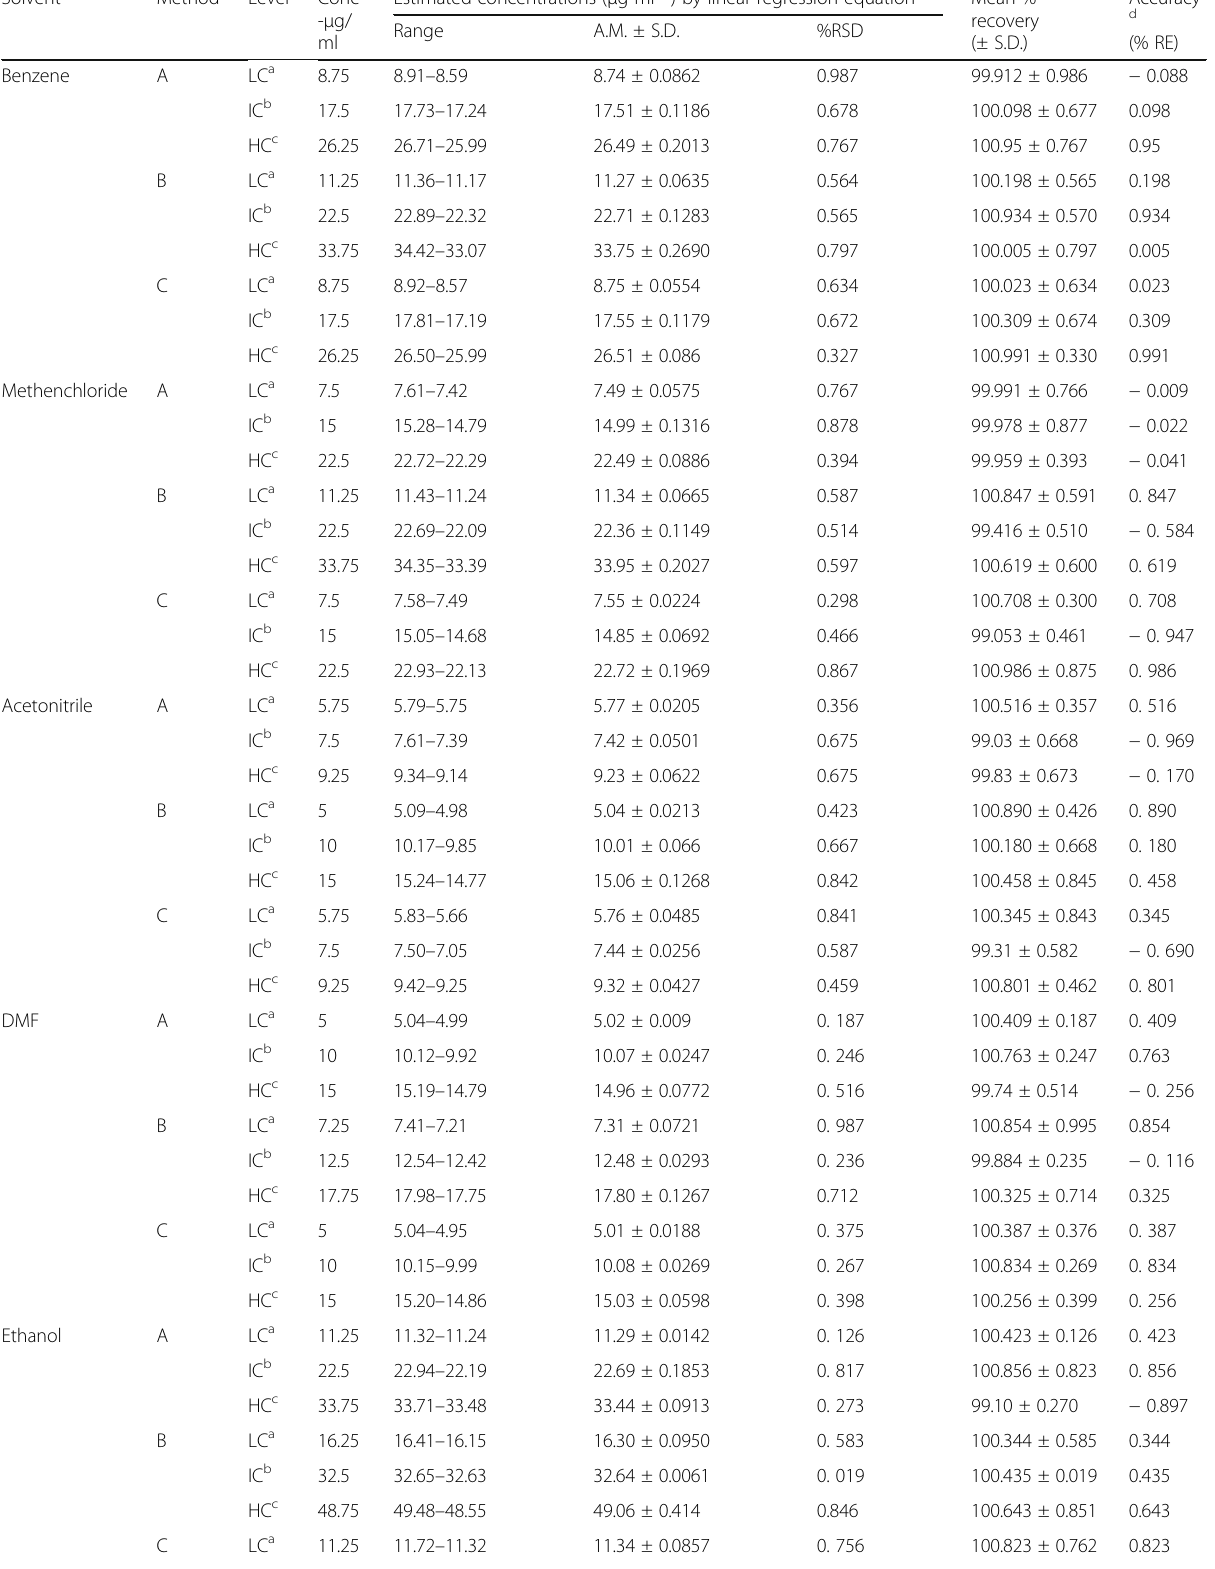
Table 3 Accuracy and precision analysis